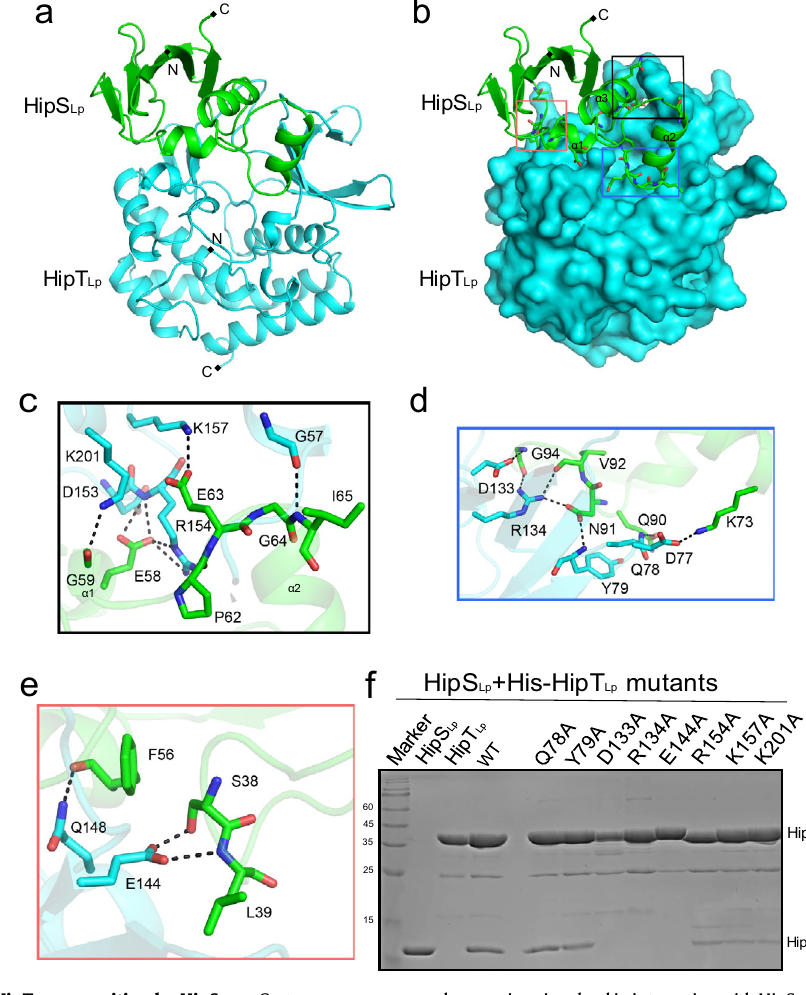
threeregionsinvolvedininteractionwithHipS Lp areencircledwithblack,blue,and red rectangles, respectively. c – e Detailed view of the three interacting regions formed between HipT Lp and HipS Lp . Interacting residues are shown as sticks and hydrogen bonds are indicated with black dashed lines. f Pull-down assays per- formed with wild-type or mutant HipT Lp carrying C-terminal 6×His-tag and untag- ged wild-type HipS Lp